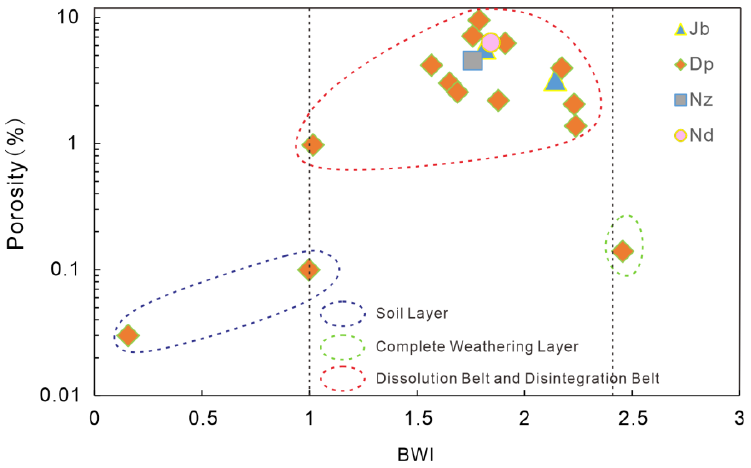
Figure 8. Cross-plot between BWI and porosity of the granitoids in north Qaidam. Jb: Jianbei Slope, Dp: Dongping Uplift, Nz: Niuzhong Slope, Nd: Niudong Uplift.